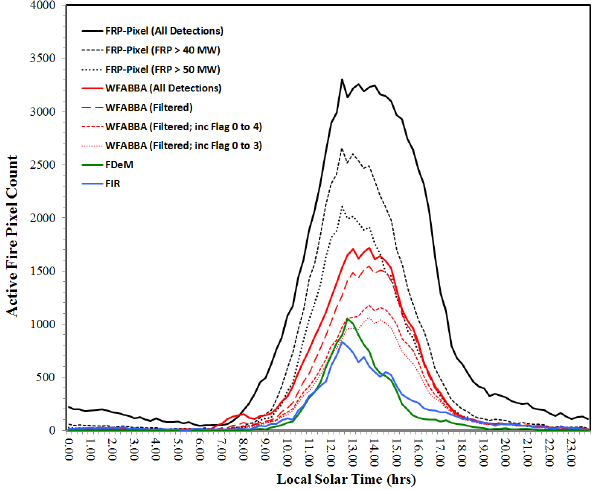
Figure 5. Diurnal cycle of active fire detections present within the four SEVIRI-derived active fire products discussed herein for the LSA SAF Southern Africa geographic region (Fig. 1) on a single day (30 August 2014). The products are the LSA SAF FRP-PIXEL product (Wooster et al., 2015), Wildfire-ABBA (WFABBA; Prins et al., 1998), FDeM (Amraoui et al., 2010) and FIR (Joro et al., 2008). All confirmed active fire detections made in each product are in- cluded here for completeness, and results are shown in terms of the local solar time of detection. For the FRP-PIXEL product, three ac- tive fire time series are shown: (1) all detections, and only those detections from fire pixels with FRP magnitudes (2) > 40MW and (3) > 50MW since it is known that increasing undercounting of active fire pixels occurs around these limits (Roberts and Wooster, 2008; and companion paper in this issue). For the WFABBA active fire detections, all four versions of the data set are included: (1) all active fire detections, (2) the WFABBA-“filtered” detections where active fire pixels only detected once during 24h are removed, and the WFABBA-filtered detections keeping only (3) the high proba- bility fires (flags 0–3) and (4) high and medium probability fires (flags 0–4). The LSA SAF FRP-PIXEL product detects a total of 89781 active fire pixels over this day, which reduces to 53561 and 39461 when restricted to fire pixels with FRP > 40MW and > 50MW respectively. For WFABBA, the total number of active fire detections is 35759, and the filtered data set contains 35759 detections which reduces to 30751 and 23957 when WFABBA low and medium probability fire detections are removed. The FDeM and FIR detect only 13477 and 14645 active fire pixels